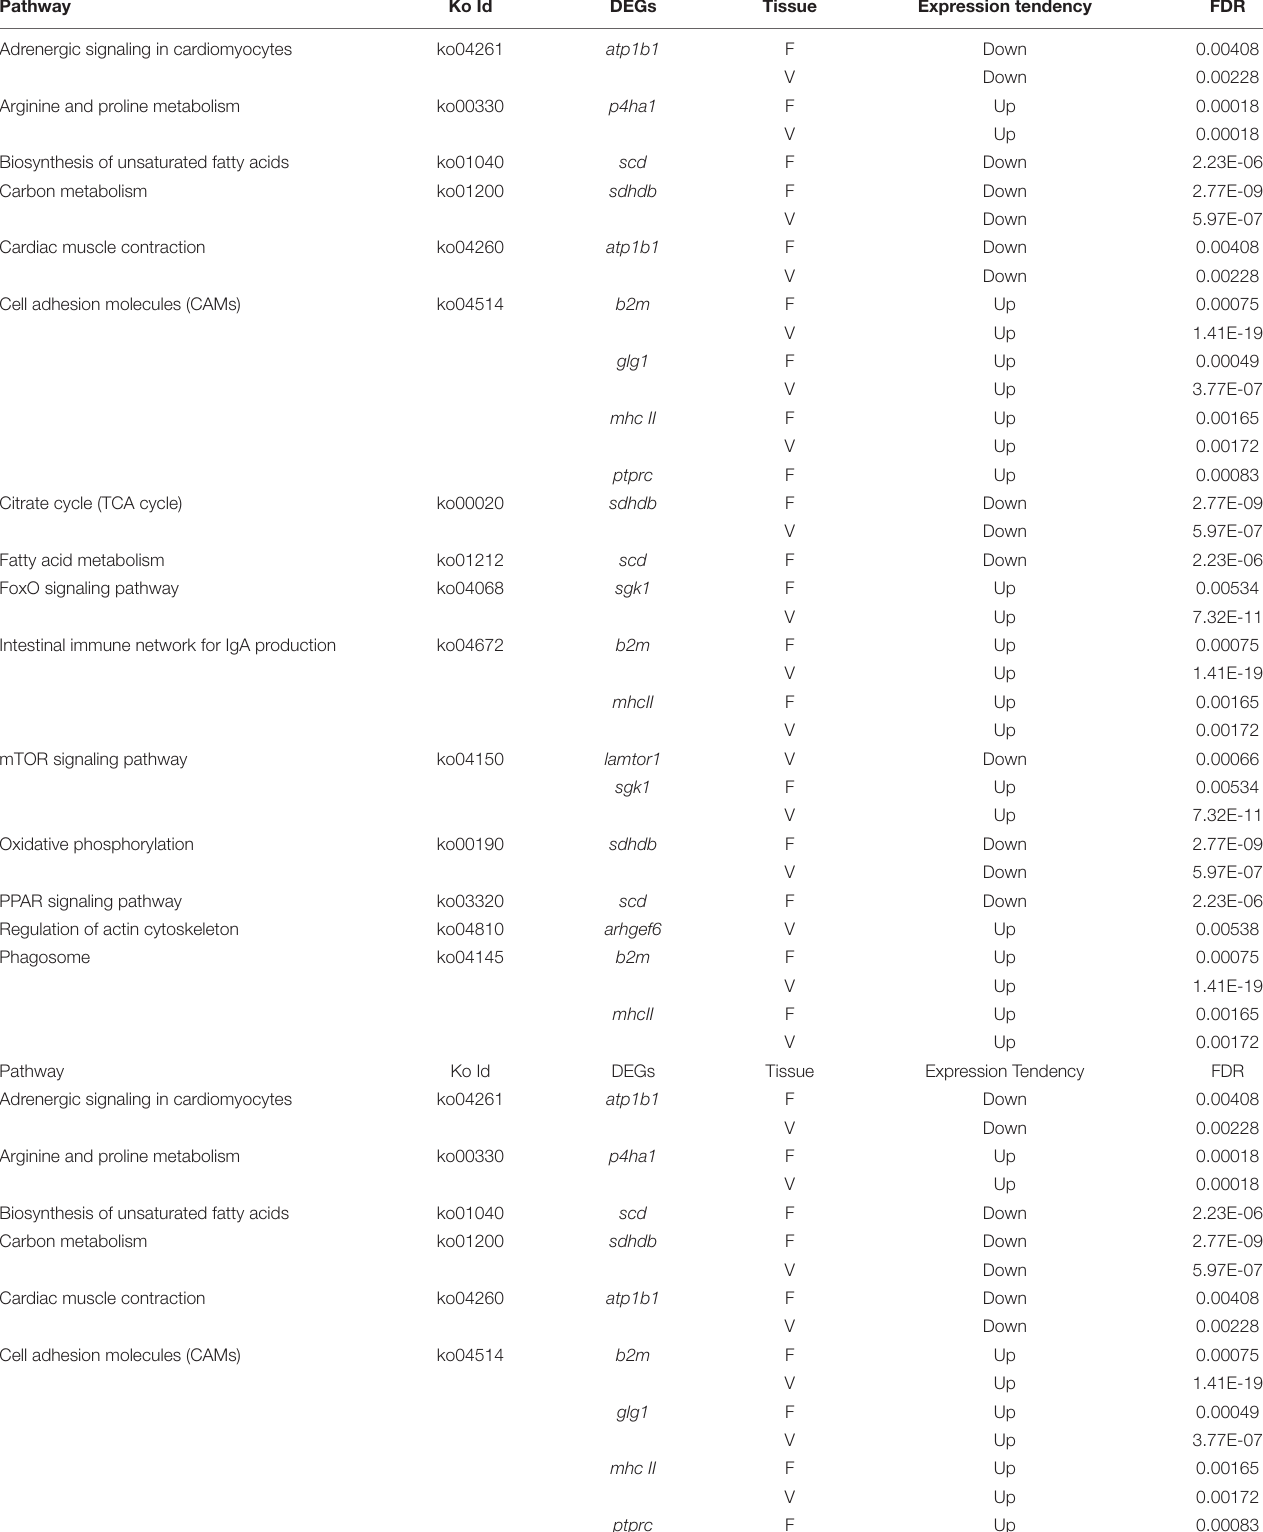
TABLE 3 | Key pathways related to early growth regulation in bone tissues of bighead